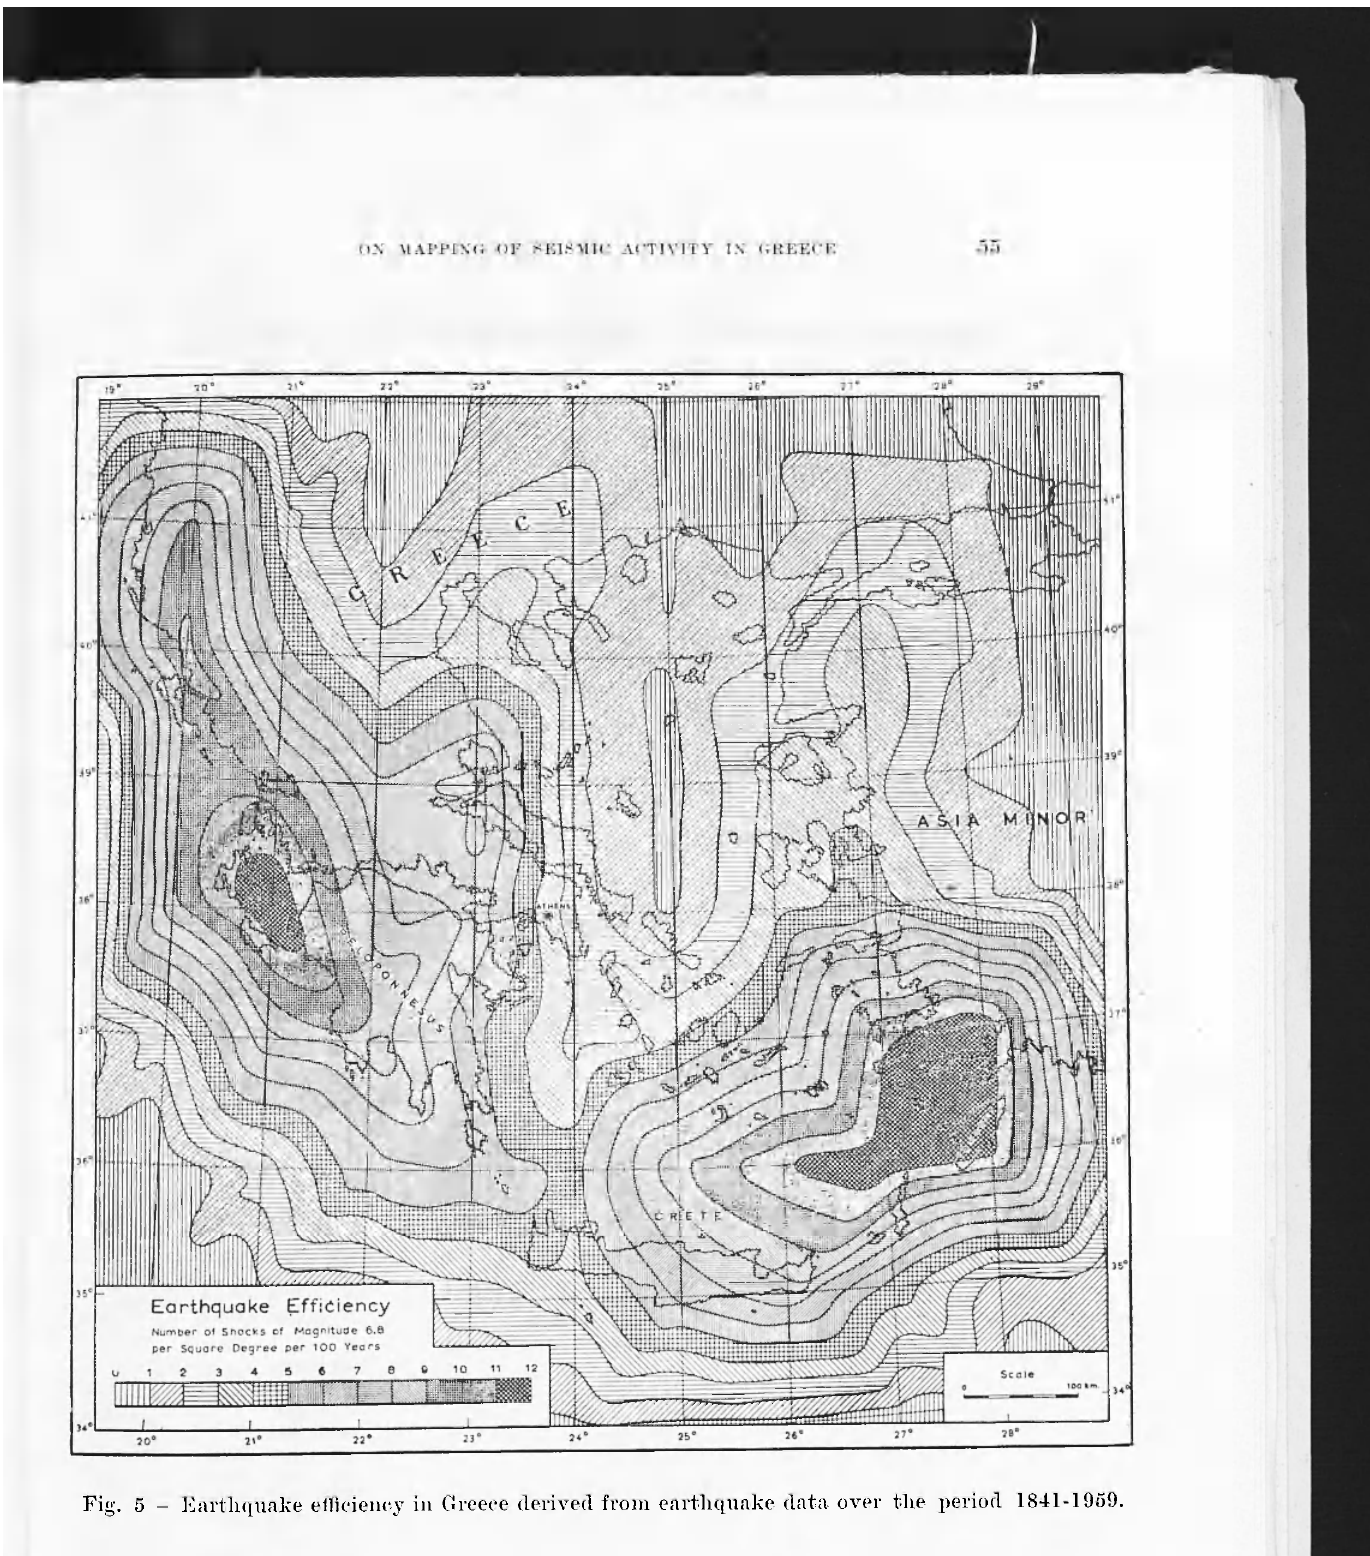
Fig. 5 - Earthquake effìciency in Greece derived from earthquake data over the period